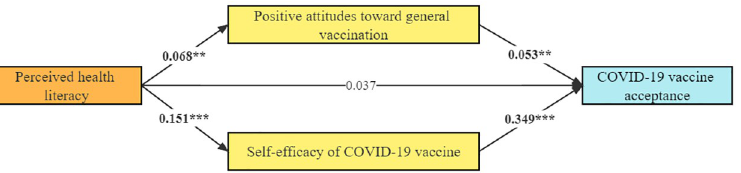
Fig 3. The mediation model of perceived health literacy on COVID-19 vaccine acceptance. The numbers on arrows represent standardized coefficients. P-values marked with bold indicate statistically significant p-values. �� p < .01; ��� p <